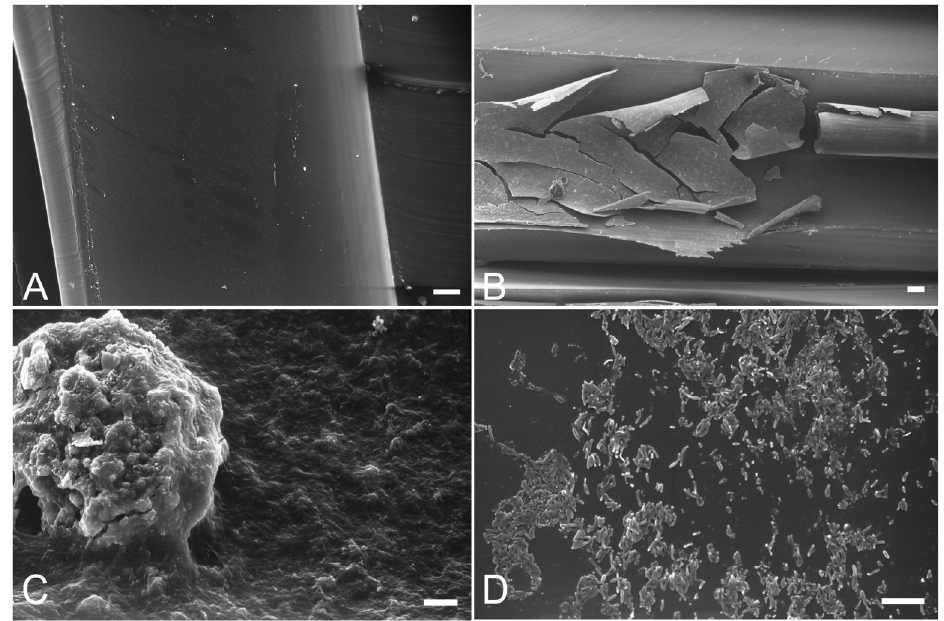
Figure 1. SEM features seen on exposed tube